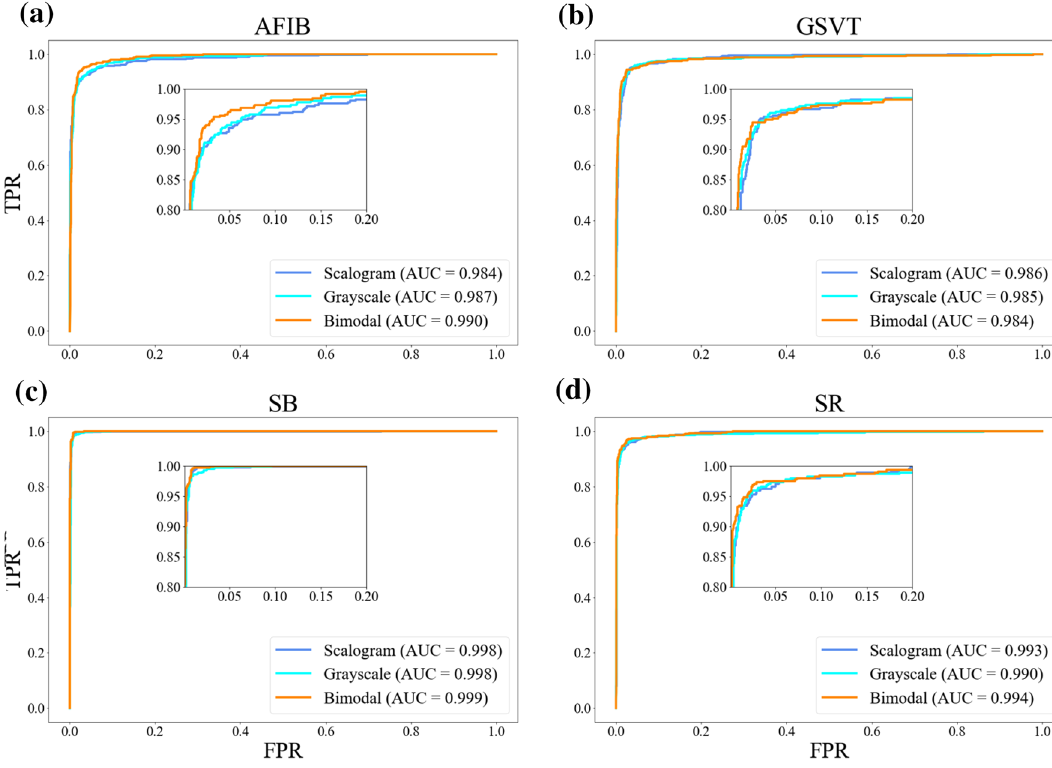
Figure 3. Comparison of the AUCs among grayscale image, scalogram, and bimodal models for lead II. TPR, true positive rate; FPR, false positive rate. ( a ) AFIB class ( b ) GSVT class ( c ) SB class ( d ) SR class. AUC ACC (%) SEN PRE F1-score Logistic regression